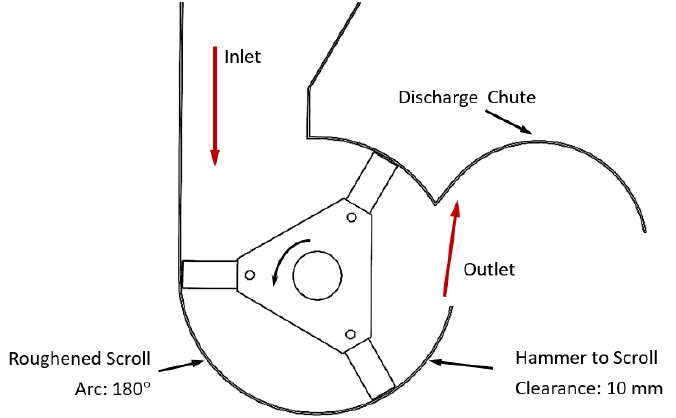
Figure 1. Schematic of impact–shredding processor.